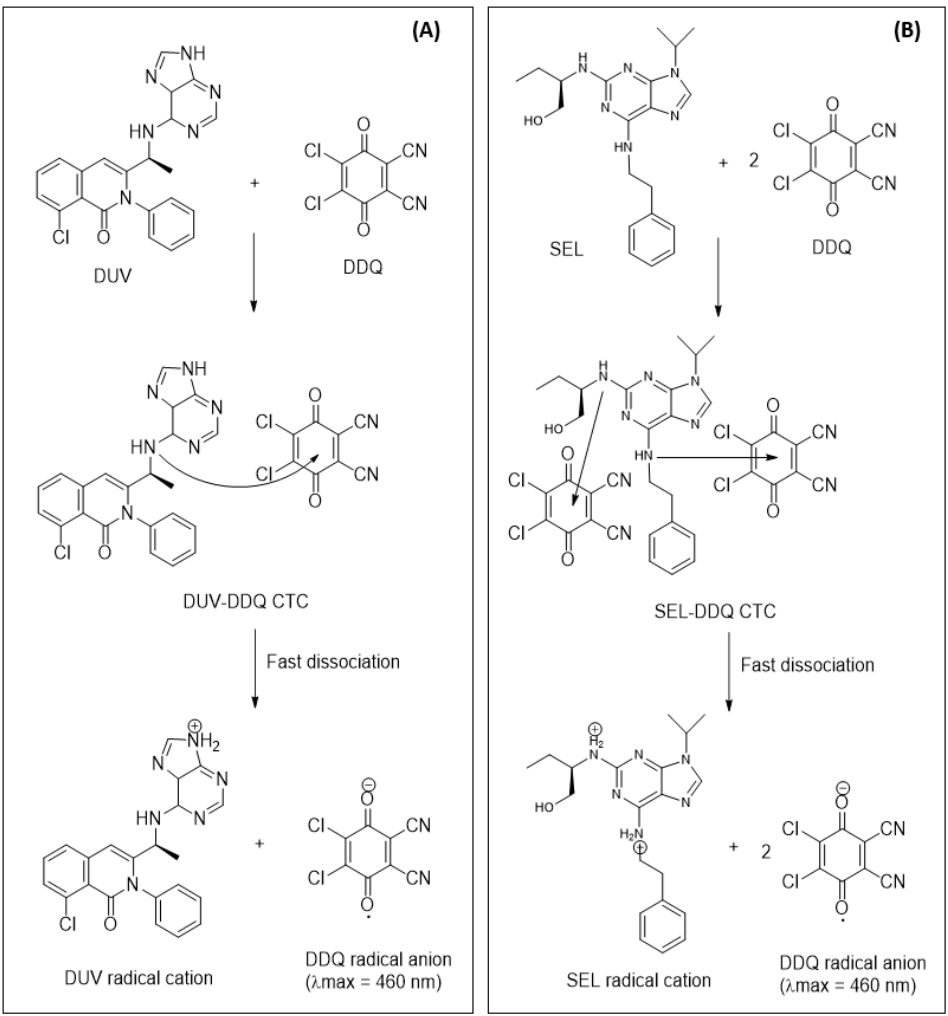
Figure 8. Schemes for the CT reaction of DUV ( A ) and SEL ( B ) with DDQ